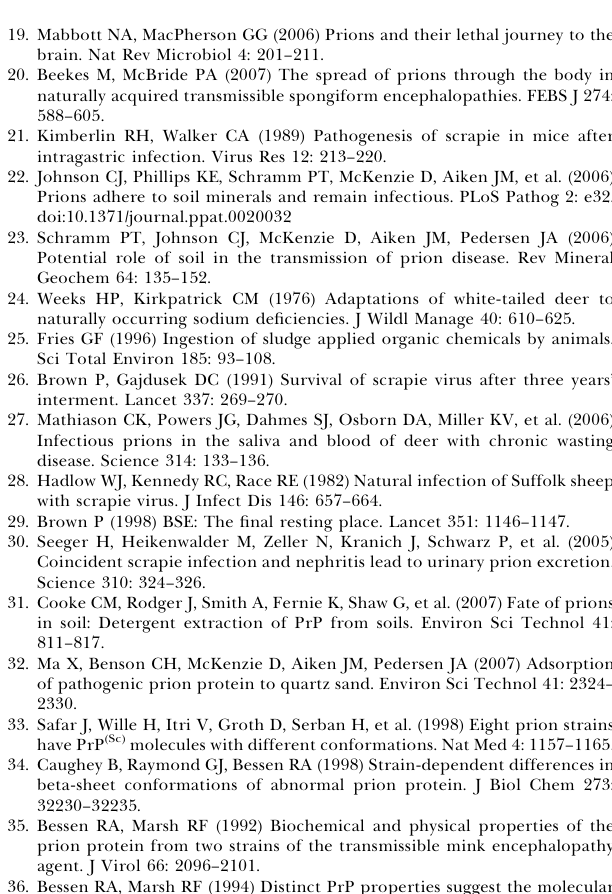
Figure S1. Typical Survival Curves for Intracerebral and Oral Inoculation of a Dilution Series of Hamster-Adapted Scrapie Agent (Prion Strain 263K) in 10% BH For the intracerebral inoculation (inset), each log 10 dilution leads to a characteristic lengthening in incubation period (adapted from Prusiner et al. [56]). Lines represent the mean incubation period of eight hamsters. Typical survival curves following peroral adminis- tration of 263K prions over a partially overlapping range of doses reveal that each log 10 dilution lengthens the incubation period and reduces disease penetrance (adapted from Baier et al. [52]). Figure S2. Immunoblot Analysis of Inocula for Experiments Examin- ing PrP TSE (cid:4) Mte Complexes and PrP TSE (cid:4) Mte Mixtures Aliquots of PrP TSE (cid:4) Mte complexes and corresponding clarified PrP TSE inocula were analyzed by immunoblotting to assess whether processing losses could account for the reduced transmission by unbound PrP TSE compared to the Mte-bound agent. One-tenth (50 l L) of the (A) 200 ng clarified PrP TSE 6 Mte samples or (B) 1 l g PrP TSE þ Mte and corresponding unbound PrP TSE samples were analyzed by immunoblotting. In both cases the Mte-bound samples contained less or similar amounts of protein compared to the unbound samples.